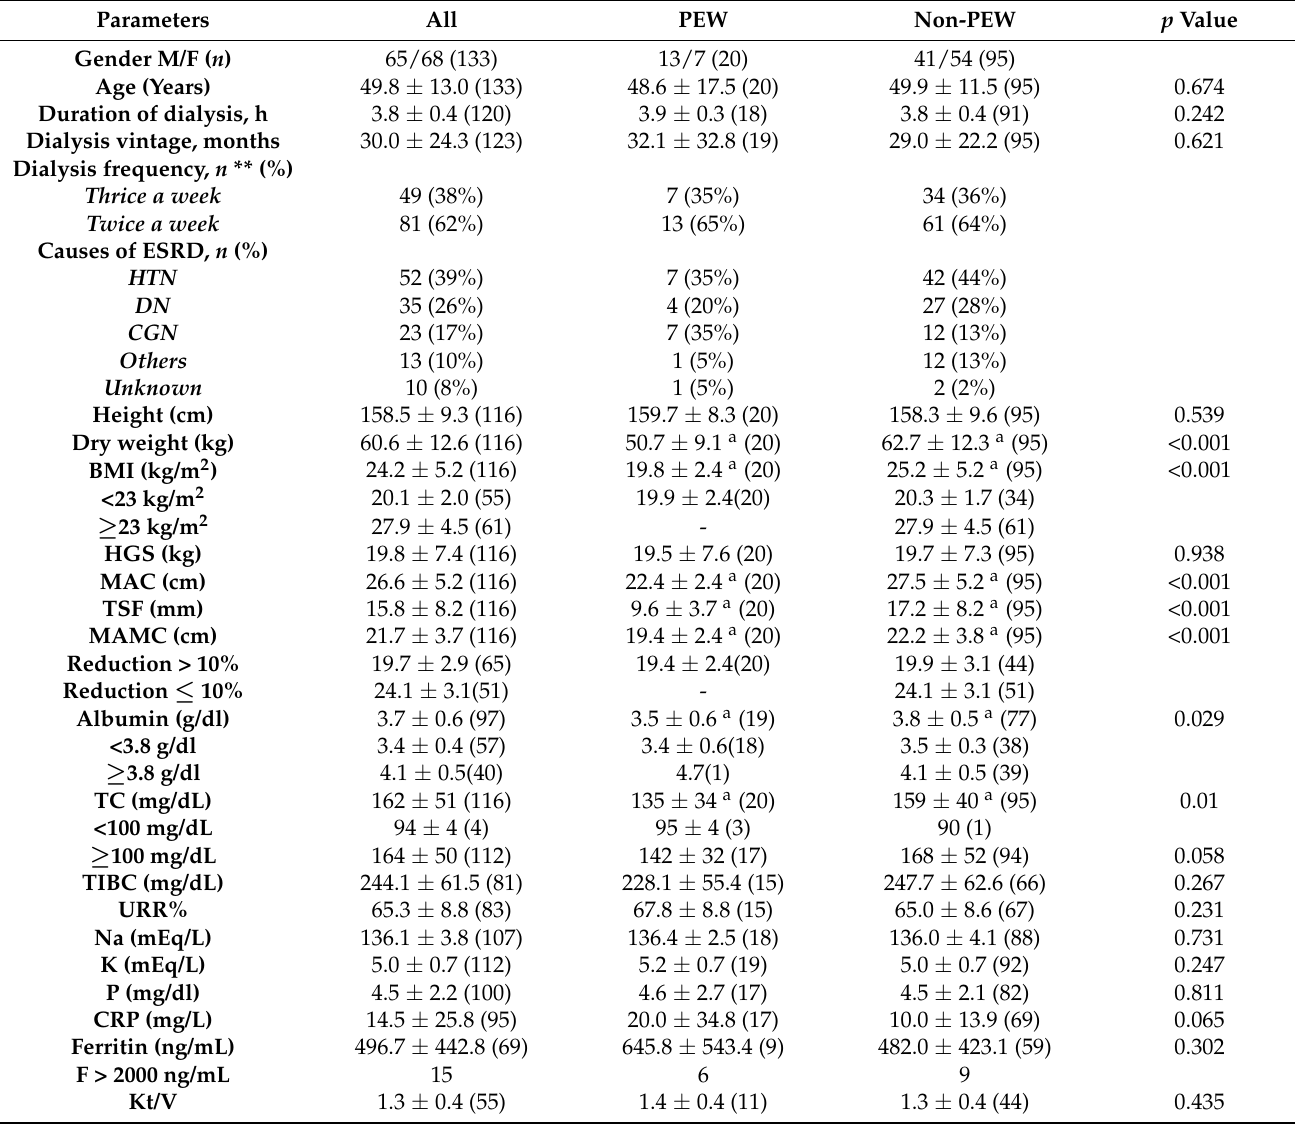
Table 1. Demographics, anthropometric and biochemical parameters: PEW versus